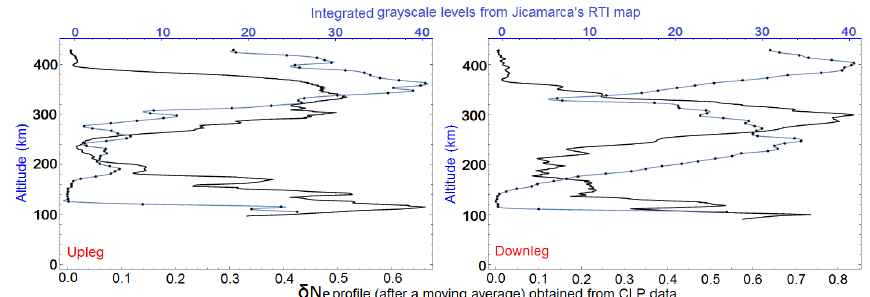
Figure 11. Irregularity fluctuation profile obtained from in situ measurements (black curve) together with the integrated SNR of the RTI maps from VHF radar measurements (blue curve and black